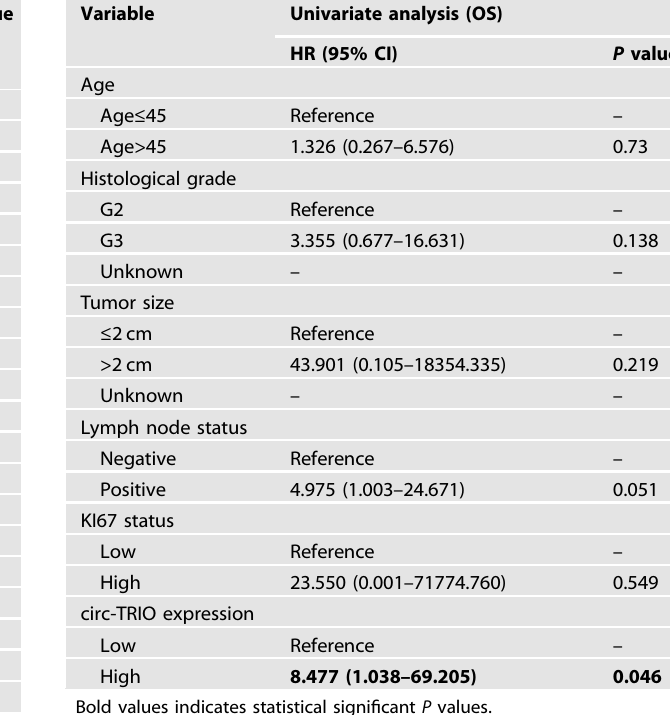
Table 3. Univariate analyses of prognostic factors (OS) for patients with